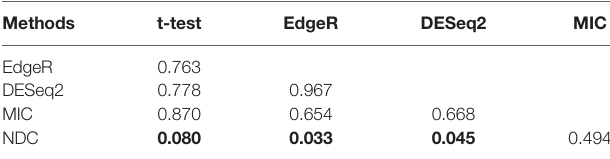
TABLE 2 | Rank correlation coef fi cient among fi ve